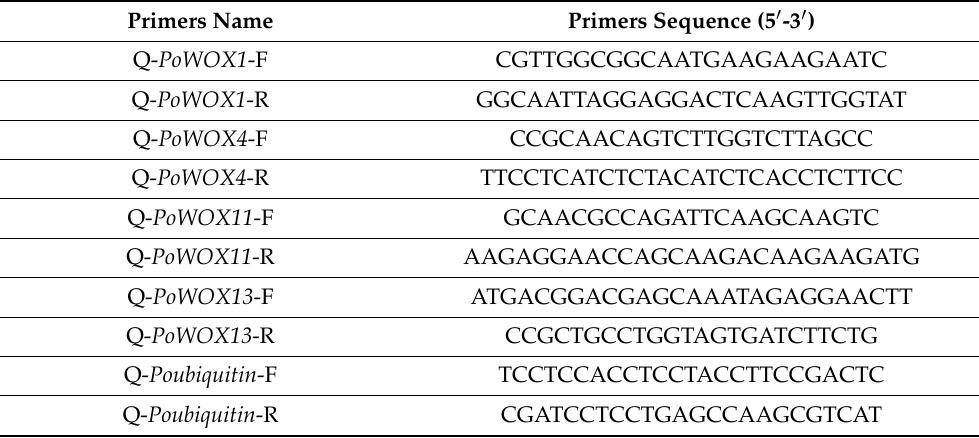
Table 2. Primer sequences of PoWOX genes for real-time quantitative.